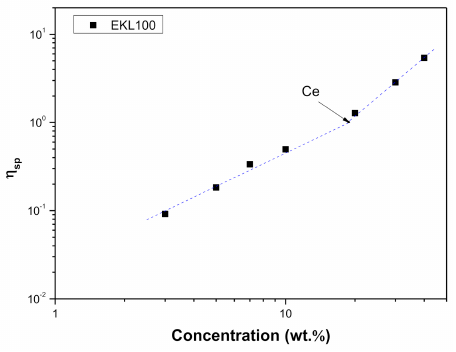
Figure 3. Specific viscosity vs. EKL concentration plot and estimation of the critical entanglement